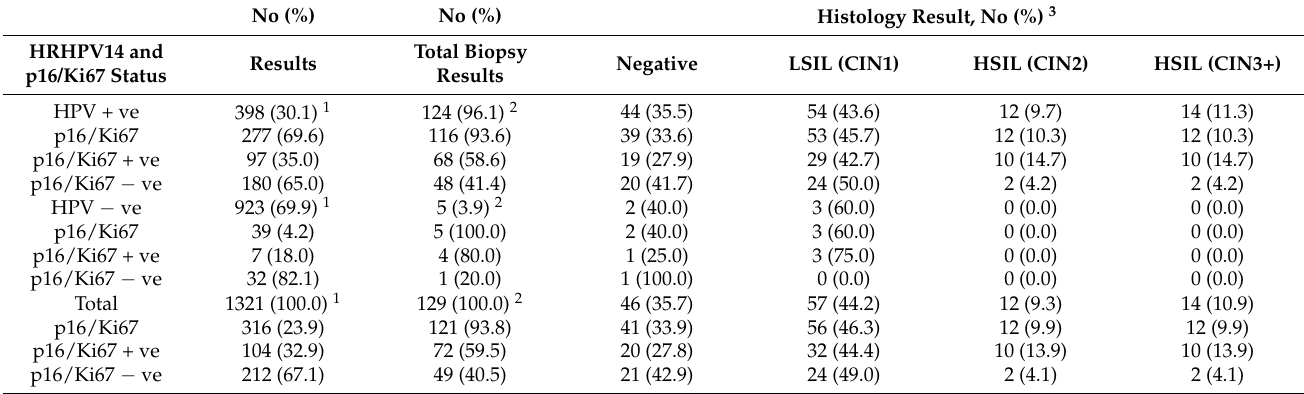
Table 3. Biopsy results with HRHPV14 and p16/Ki67 status from baseline to final study